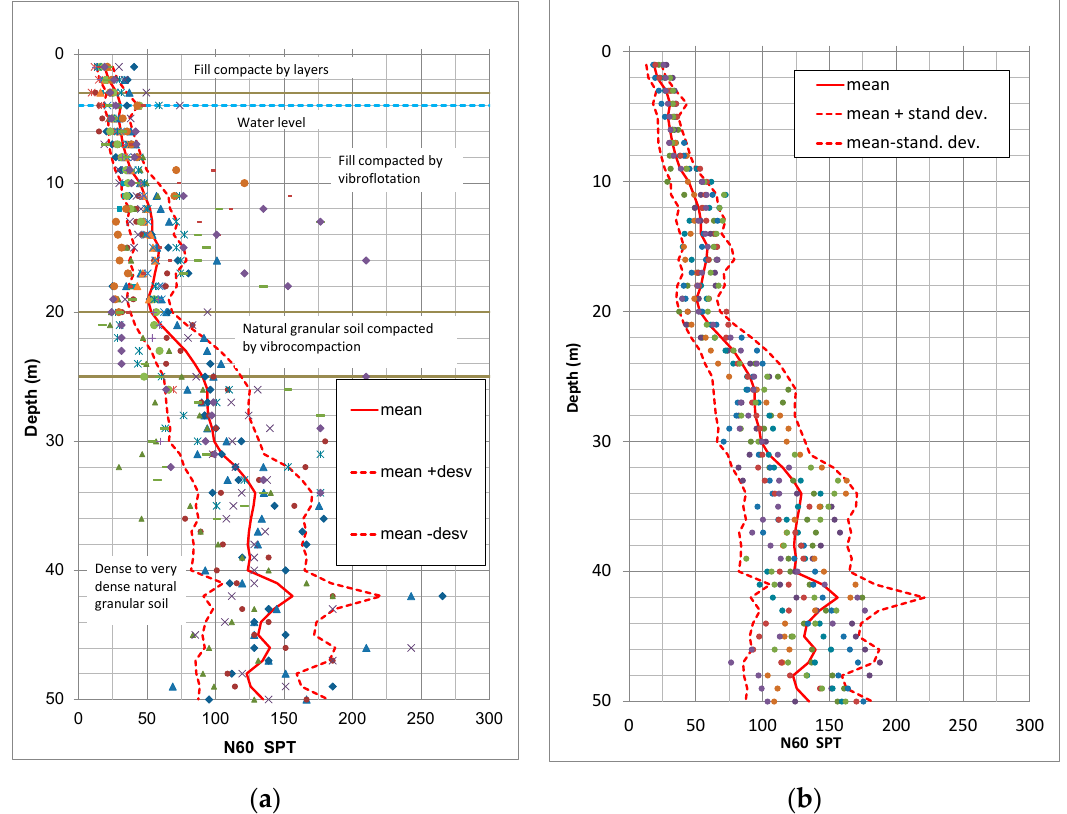
Figure 4. N SPT representation: ( a ) Example of a statistical representation of the SPT-parameter corrected by method and statistical uncertainty; ( b ) Artificial SPT profile generated by probabilistic Monte Carlo Method.